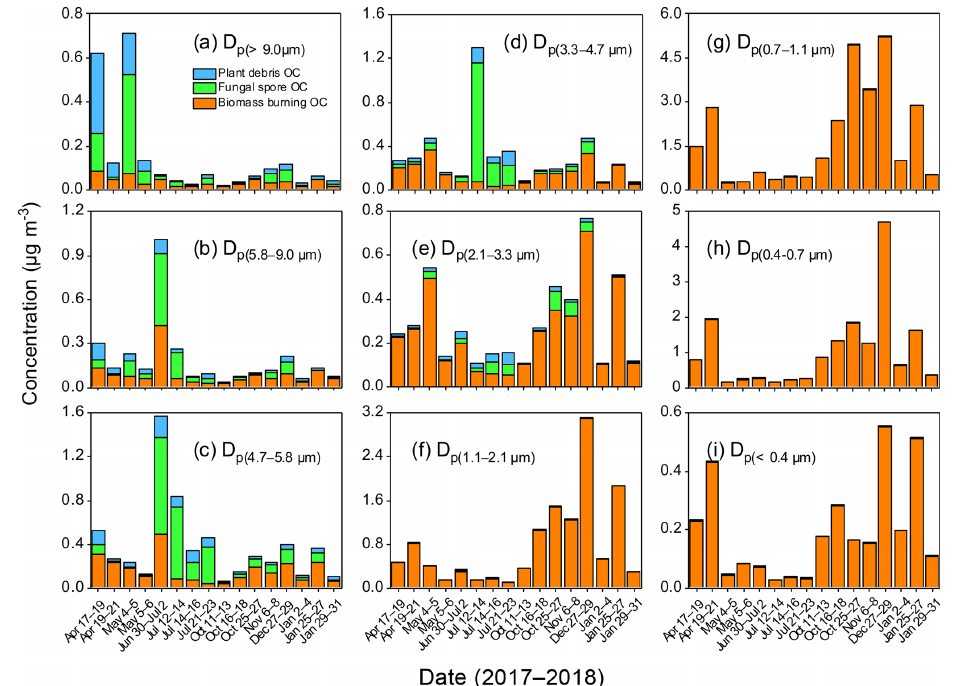
Figure 9. Concentrations of OC derived from plant debris, fungal spores and biomass burning in different size ranges of urban aerosols in